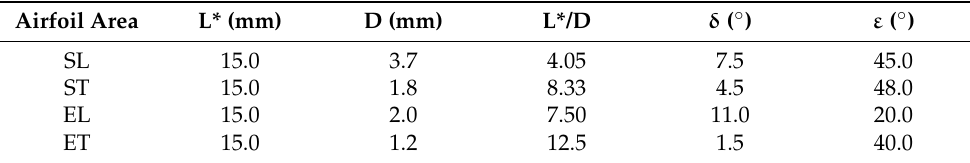
Figure 4. Model scheme of the areas SL and ST of the bottom sample, as well as the areas EL and ET of the upper sample of the blade airfoil with the characteristic parameters of the blades geometry. Table 2. Characteristic geometric parameters of the SL, ST, EL and ET airfoil areas.